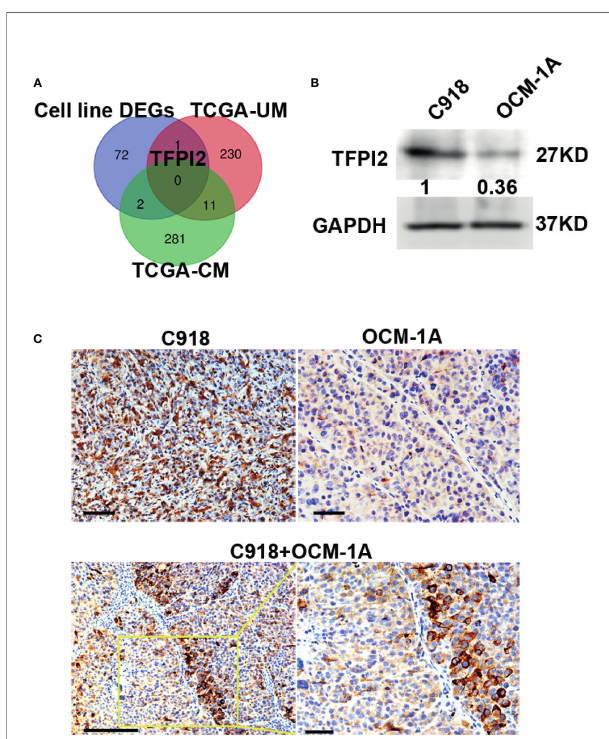
FIGURE 4 | High levels of TFPI2 in the highly invasive melanoma cell line. (A) A Venn diagram shows overlaps of DEGs from three datasets. TFPI2 was consistently upregulated in the C918 cell line and metastasis (+) UM. (B) Western blotting shows higher levels of TFPI2 in C918 cells than in OCM- 1A cells in whole cell lysate. (C) Representative IHC images stained for TFPI2 showing strikingly strong and weak expression of TFPI2 in xenografts of C918 and OCM-1A cells, respectively (upper panel). TFPI2-positive melanoma cells predominately disposed along the vascular channels in the coxenograft (C918 + OCM-1A) (lower panel). Scale bar 50 m